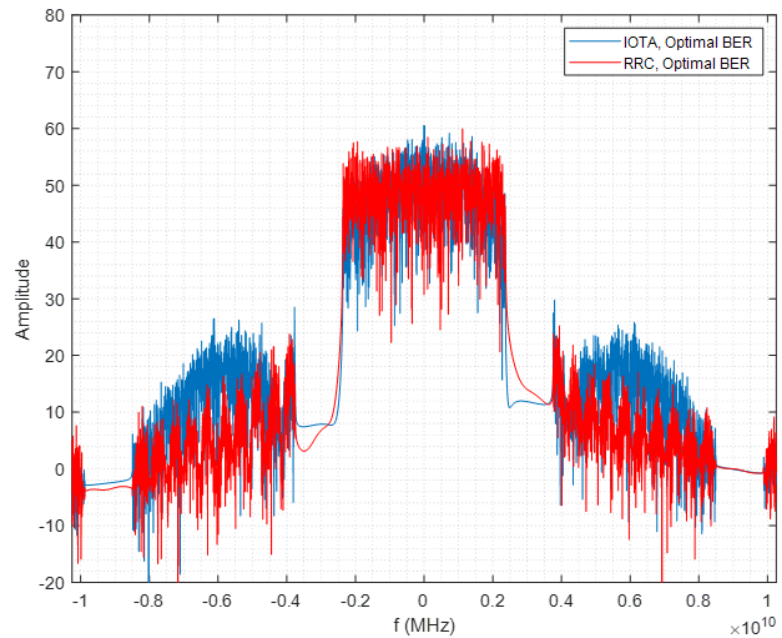
Figure 2. OOB performance of IOTA